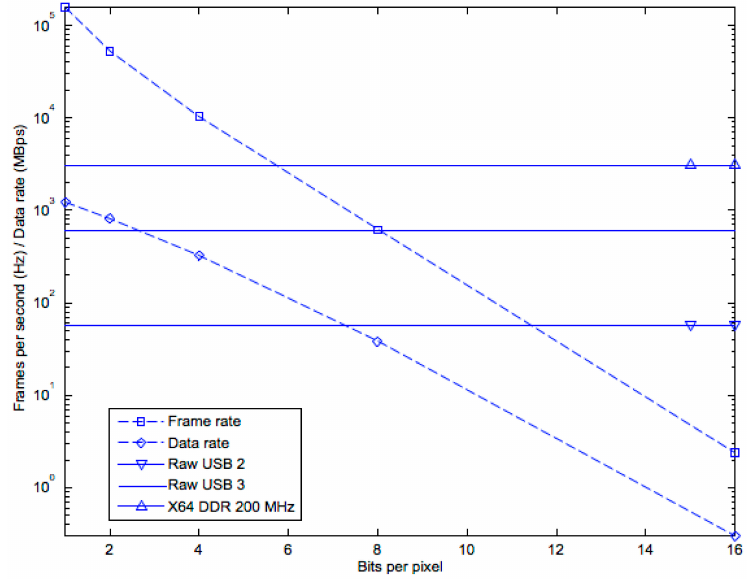
Figure 16. Tradeoff between pixel ENOB and EFPS in SwissSPAD. X64 DDR, USB-2, and USB-3 are shown as horizontal lines to represent maximal supported data rates.